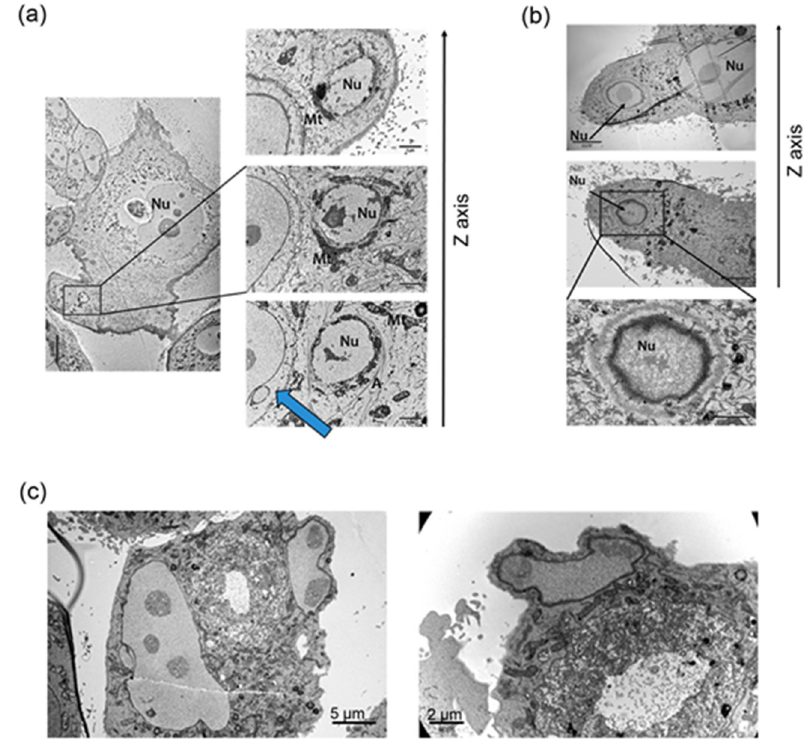
Figure 3. Formation of small offspring cells during escape from TIS. ( a ) Subnucleus surrounded by actin filaments and mitochondria. Blue arrow shows a separate small cancer cell, surrounded by a senescent polyploid one. Representative pictures of senescent and polyploid MCF-7 cells after 24 h of IRI treatment; picture taken on D8 after treatment. ( b ) Formation of a subnucleus inside the senescent cell with mitochondria surrounded by a cell membrane. Representative pictures of senescent and polyploid MCF-7 cells after 24 h of IRI treatment and eight additional days. ( c ) Protrusion of a subnucleus inside the senescent cell with mitochondria. Representative pictures of senescent and polyploid HCT116 cells after 24 h of IRI treatment; picture taken on D8 after treatment. Nu—nuclei, Mt—mitochondria, A—actin. Pictures taken with the use of transmission electron microscopy.